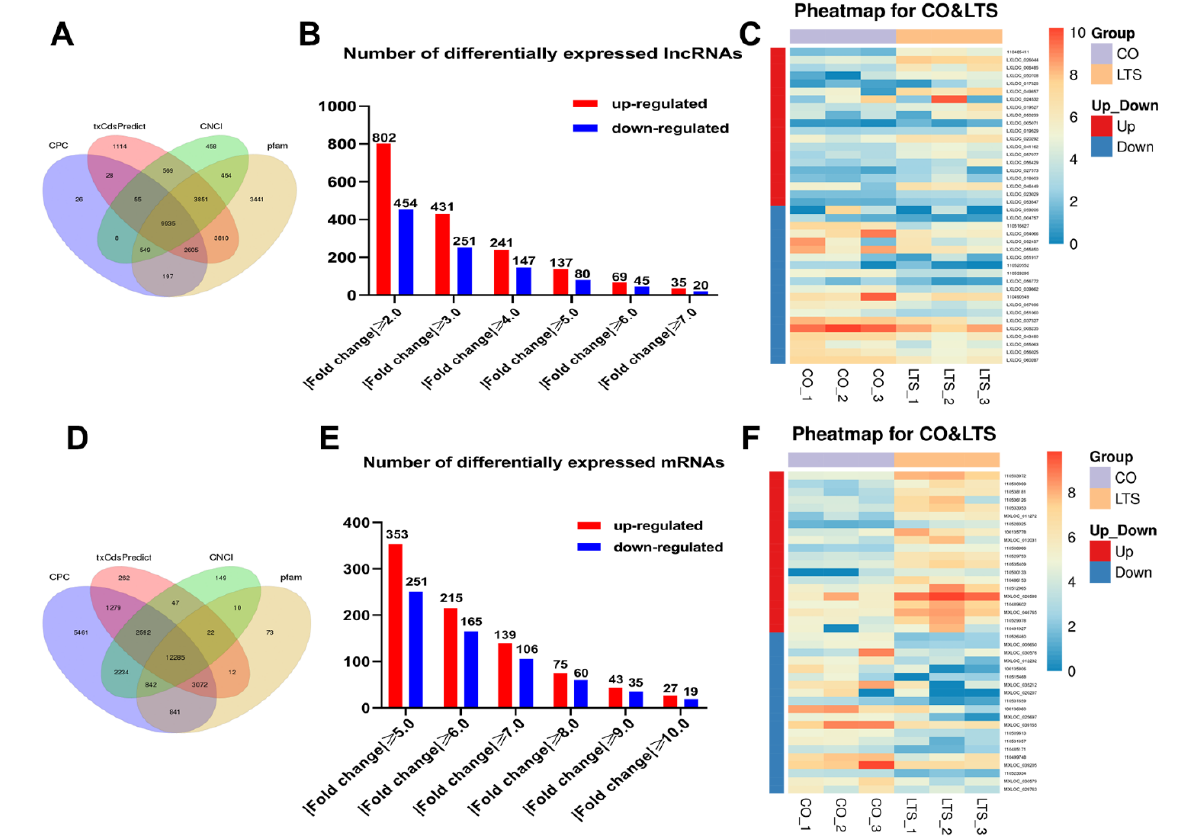
Figure 2. The expression profiling changes of lncRNAs and mRNAs in the head kidney of rainbow trout after post-22.5 °C stress. ( A ) Coding ability predicts outcomes of lncRNAs. ( B ) The statistical results of the number of lncRNAs. ( C ) The heat maps of the top 20 lncRNAs differential genes up- regulated and down-regulated, respectively. ( D ) Coding ability predicts outcomes of mRNAs. ( E ) The statistical results of the number of mRNAs. ( F ) The heat maps of the top 20 mRNAs differential genes up-regulated and down-regulated, respectively.